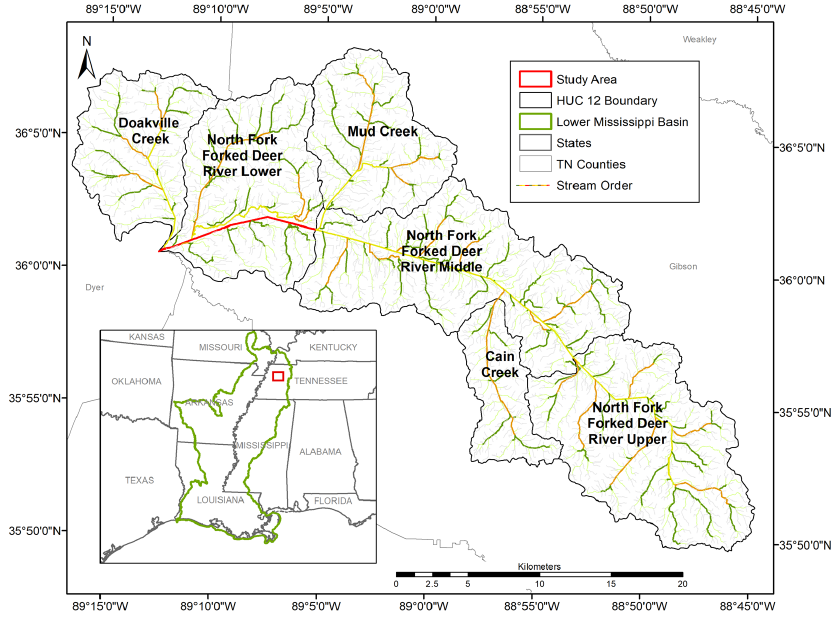
Figure 1. Location of the study area in the lower Mississippi water resource region, including six USGS HUC-12 sub-watersheds. The watershed consists of six USGS 12-digits hydrologic-unit code (HUC-12), re- ferred to as sub-watersheds by the U.S. Geological Survey (Figure 1). The North Fork Forked Deer River Upper covers a total area of 147.80 km 2 with an average slope of 7%. Predominant land uses include agricultural cropland (38%), forest (36%), pastures (19%), and developed land (7%). Cain Creek is in the southernmost region with a total area of 43.56 km 2 with average slopes of 6.0%. Predominant land uses include agricultural cropland (59%), forest (18%), pastures (10%), and developed land (13%). Mud Creek is in Gibson County. It covers a drainage area of 84.64 km 2 and has an average slope of 4.89%. Predominant land uses within this sub-watershed include agricultural cropland (78%), forest (11%), pastures (4%), and developed land (7%). The North Fork Forked Deer River middle is the largest of the HUC-12 divisions with a total area of 161.13 km 2 and an aver-